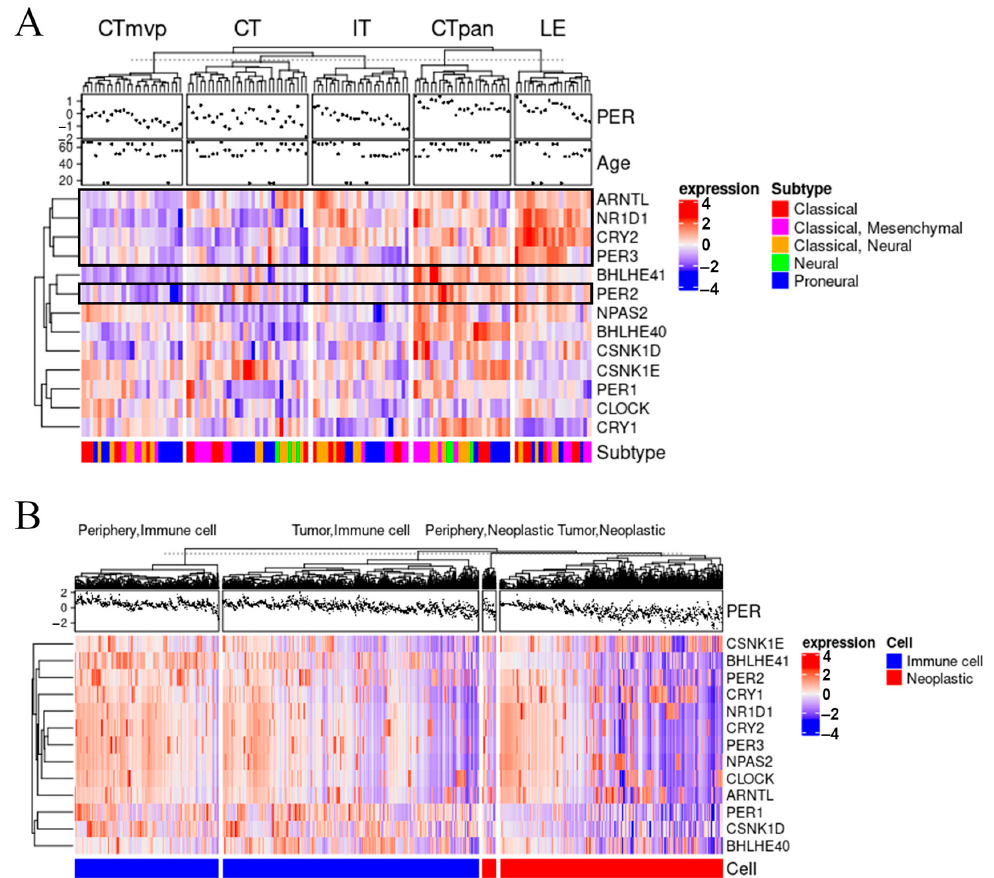
Figure 4. Differential clock gene expression by tumor location and cell type. ( A ) Heatmap generated from the IvyGap dataset showing the upregulation (red) and downregulation (blue) of clock genes across anatomical locations of glioblastoma tumors: Leading Edge (LE), Pseudopalisading cells around necrosis (CTpan), Infiltrating Tumor (IT), Cellular Tumor (CT), and Microvascular proliferation (CTmvp). Core clock genes are highlighted in the black boxes. ( B ) Heatmap generated from the Darmanis dataset showing the upregulation (red) and downregulation (blue) of clock genes in neoplastic and immune cells in the core and the periphery of the tumor.